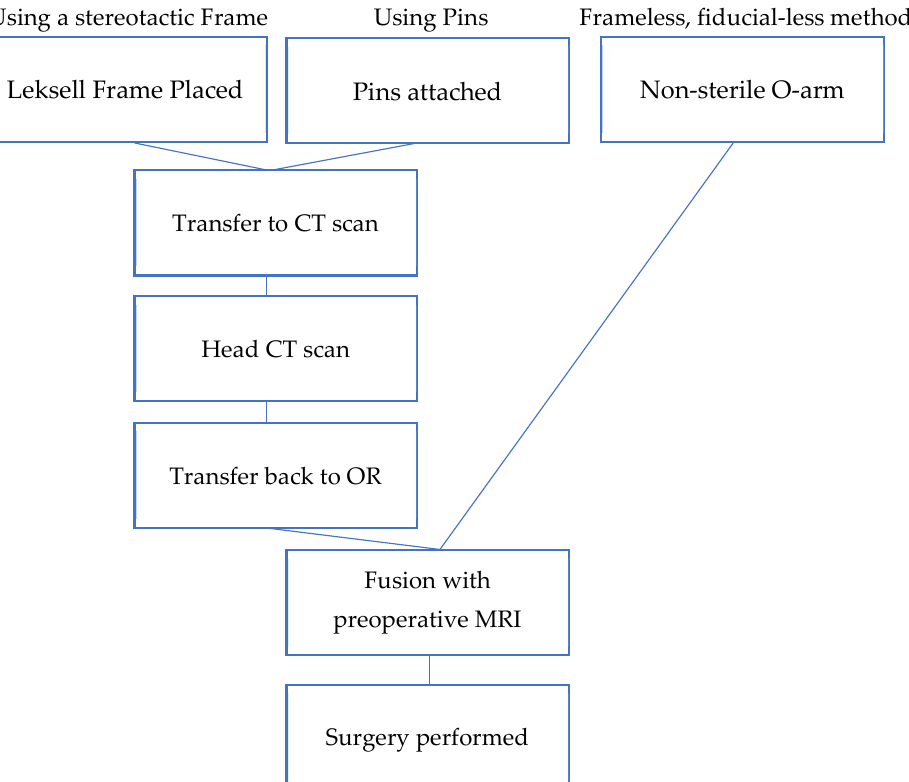
Figure 4. Flowchart comparison of older stereotactic methods with frameless, fiducial-less method.